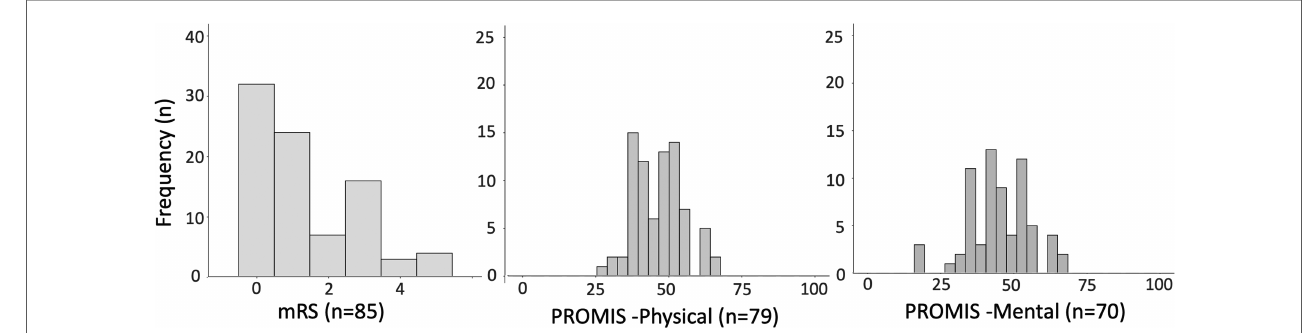
FIGURE 3 Distributions of 90-day outcomes (mRS, PROMIS Physical, and PROMIS Mental) gathered via SMS texting. SMS, short message service; mRS, modi fi ed Rankin scale; PROMIS Physical, Global Physical Health Score; PROMIS Mental, Global Mental Health Score.